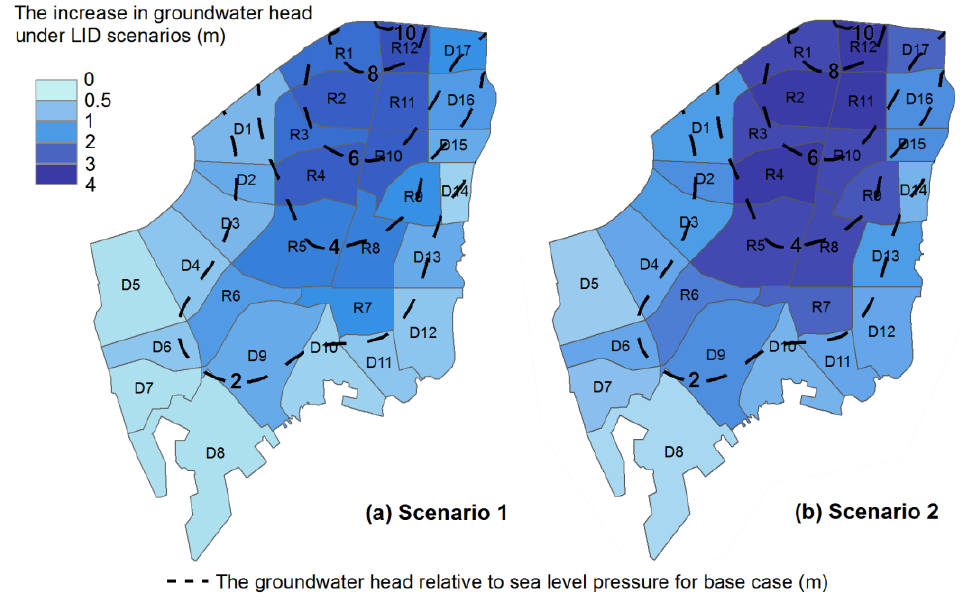
Figure 8. The increase in groundwater head under ( a ) Scenarios 1 and ( b ) Scenario 2. The increase in groundwater (GW) head = GW head relative to sea level pressure for Scenario 1 or Scenario 2 − GW head relative to sea level pressure for the base case.